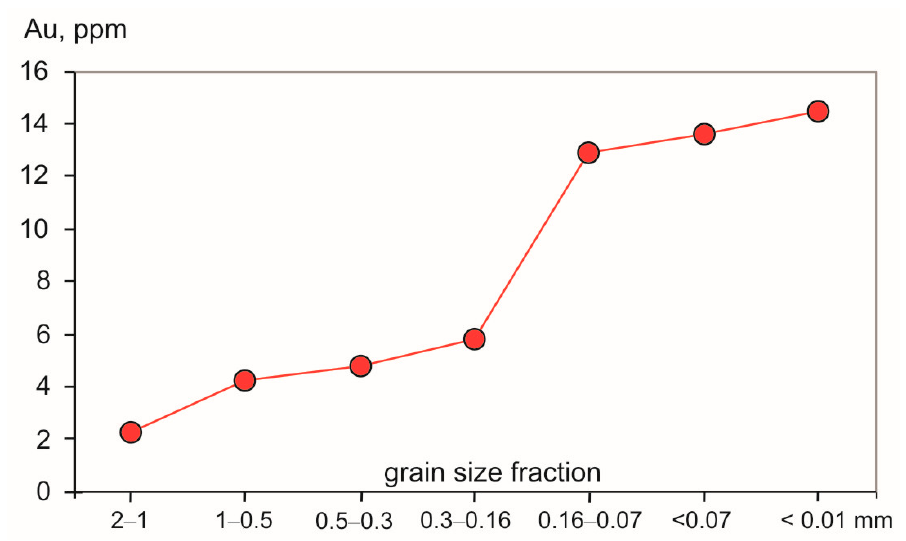
Figure 10. The graph of increasing Au concentration with decreasing size fraction of rock crushing.